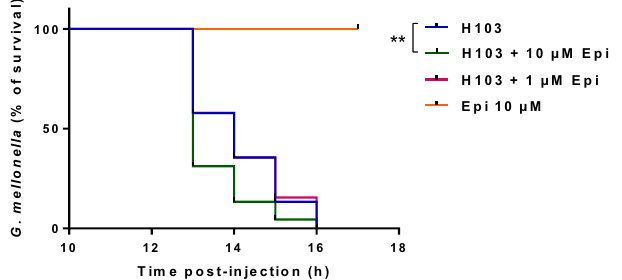
Figure 5. Virulence assay on G. mellonella . The virulence of P. aeruginosa H103 was tested towards the caterpillar G. mellonella larvae, during 17 h. Log-rank (Mantel-Cox) test was used, ** p =